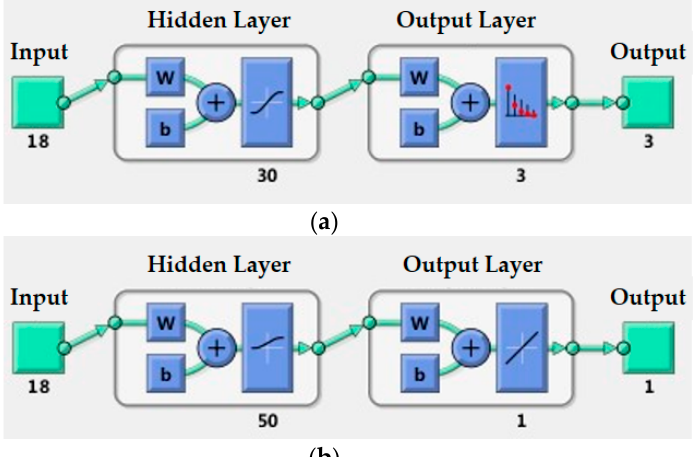
Figure 6. Back propagation (BP) neural network structure for object curvature discrimination: ( a ) single hidden layer surface type classification neural network structure; ( b ) single hidden layer curvature radius estimation neural network structure.